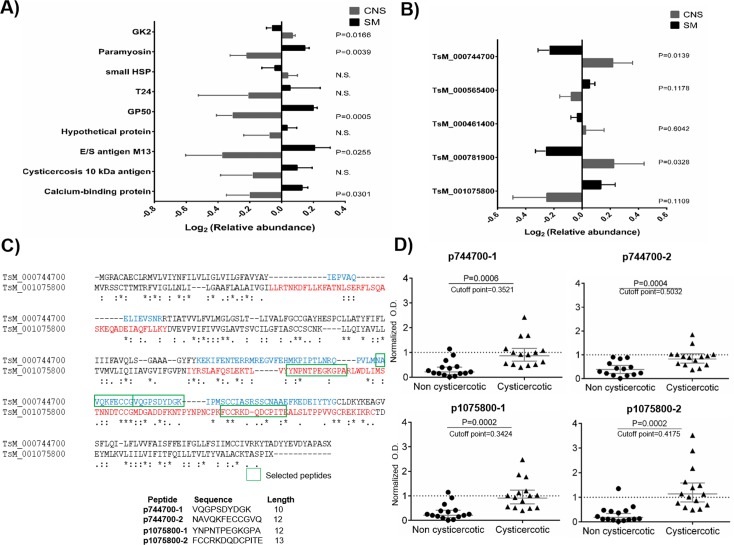
Protein abundance of several well-studied antigens in T. solium cysts antigens.A) Relative abundance of cyst’s antigens obtained from the skeletal muscle (SM) and central nervous system (CNS); B) Relative abundance of tetraspanin proteins quantified in our proteomic analysis for SM and CNS cysts; C) Alignment of SM- and CNS-abundant tetraspanins. The extracellular loops are bold in red and blue, selected peptides are marked by a square. Listed at the bottom are the selected peptide sequences and length. D) Recognition of the synthetic peptides by non cysticercotic and cysticercotic pig sera. The normalized optical density (O.D.) is the result of dividing each individual O.D. by the cut-off value (mean value of non cysticercotic pigs plus two standard deviations). P-values are shown at the top of each figure.